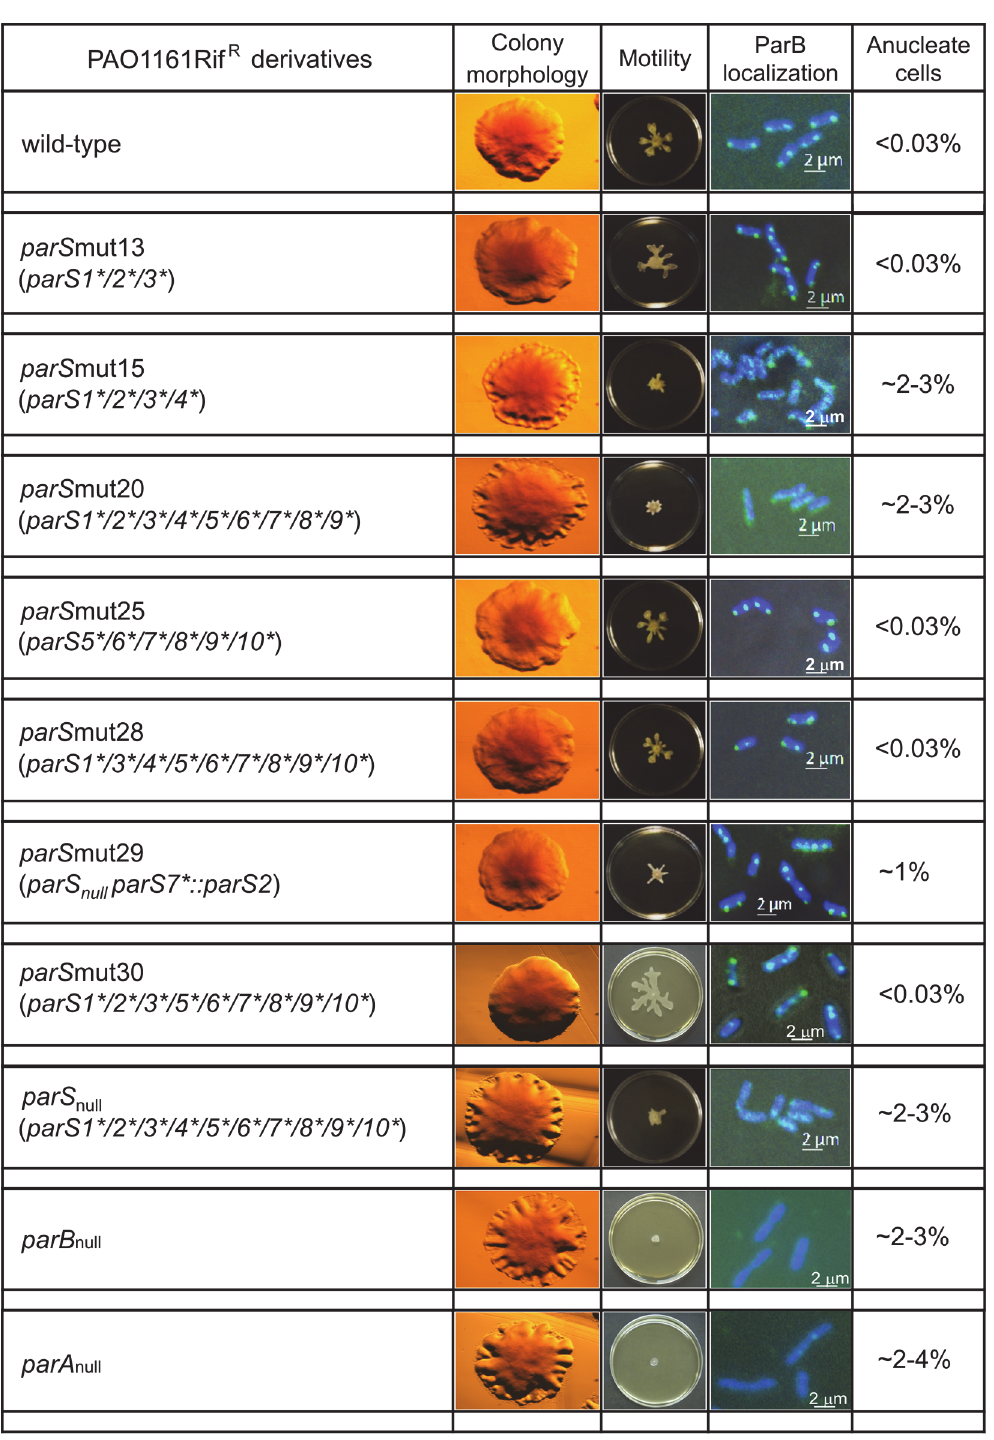
PLOS ONE | DOI:10.1371/journal.pone.0120867 March 20,